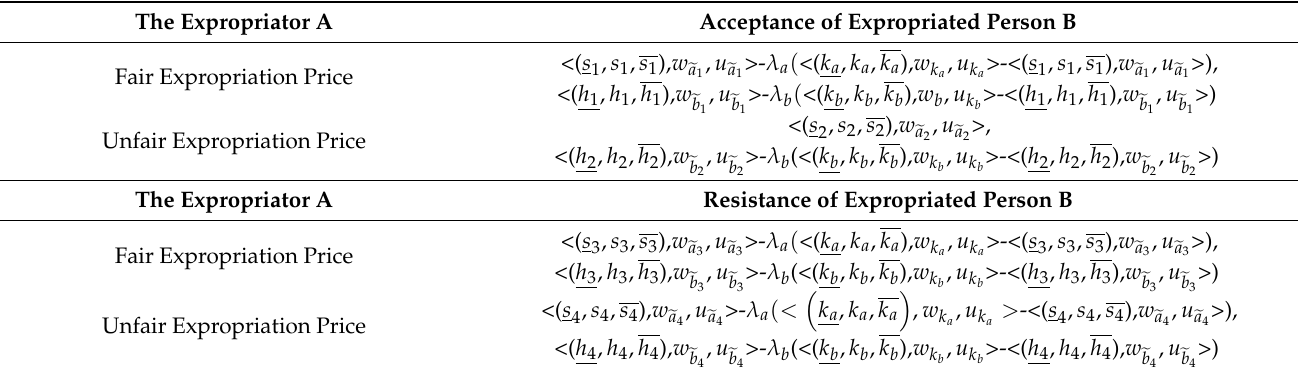
Table 2. Loss aversion fair fuzzy equilibrium evaluation